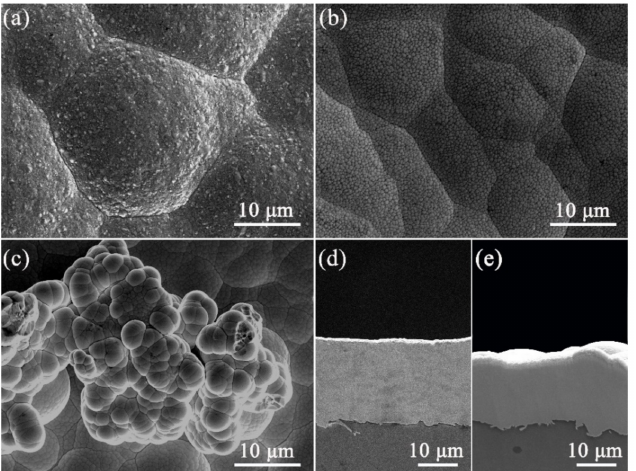
Figure 2. The surface morphologies of ( a ) pure Ni, ( b ) Ni-B, and ( c ) Ni-B-GO. The cross sections of ( d ) Ni-B and ( e )